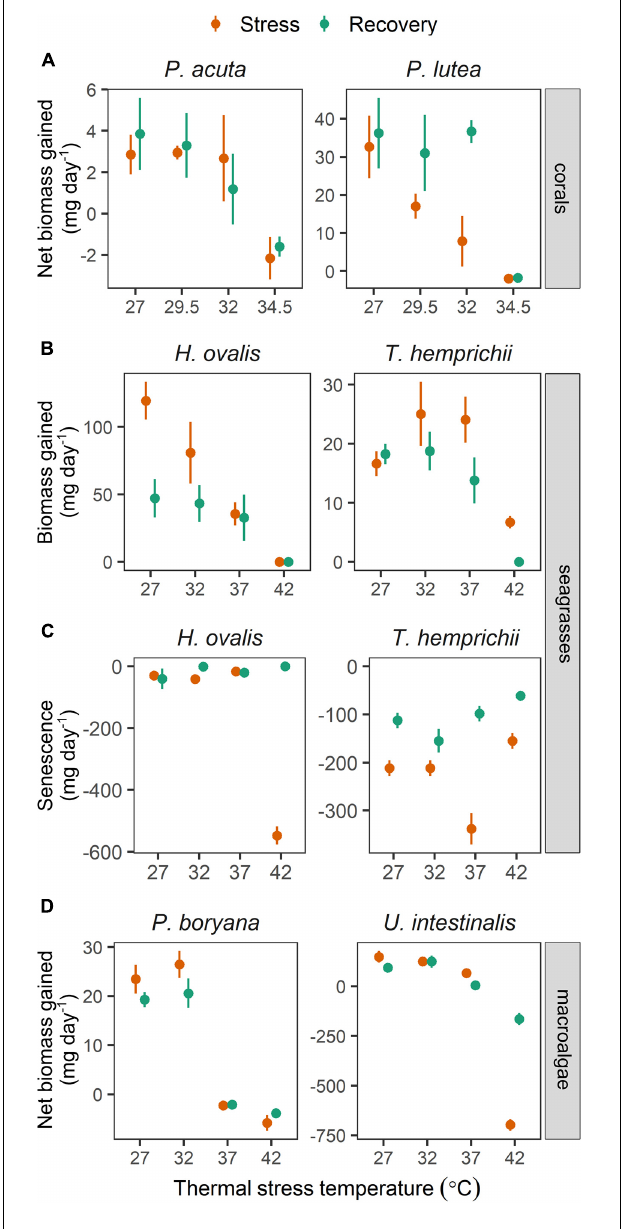
FIGURE 5 | The effects of experimental temperatures on growth rates of corals, seagrasses and macroalgae during stress and recovery periods. (A) Net biomass increase in corals, (B) biomass increase in seagrasses, (C) senescence (biomass loss) in seagrasses and (D) net biomass increase in macroalgae. Values are shown as mean ± SE ( n = 3). For each replicate, 3 individuals were examined. Corals were subjected to 27–34.5 ◦ C in stress period and 27 ◦ C in recovery period. Seagrasses and macroalgae were subjected to 27–42 ◦ C in stress period and 32 ◦ C in recovery